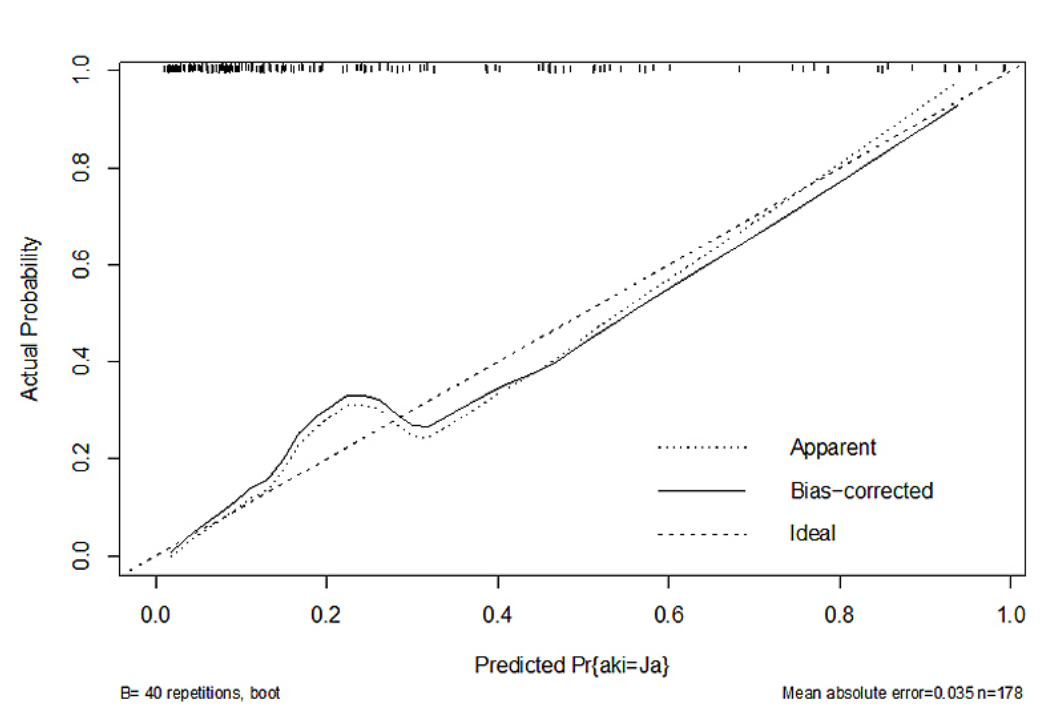
Figure S2: Calibration plot for the prediction of acute kidney injury. The calibration function of the rms package was used for this plot. Boot- strapping using 40 repetitions were used to get bias corrected estimates of the predicted versus the actual probability. An underprediction was observed at lower predicted